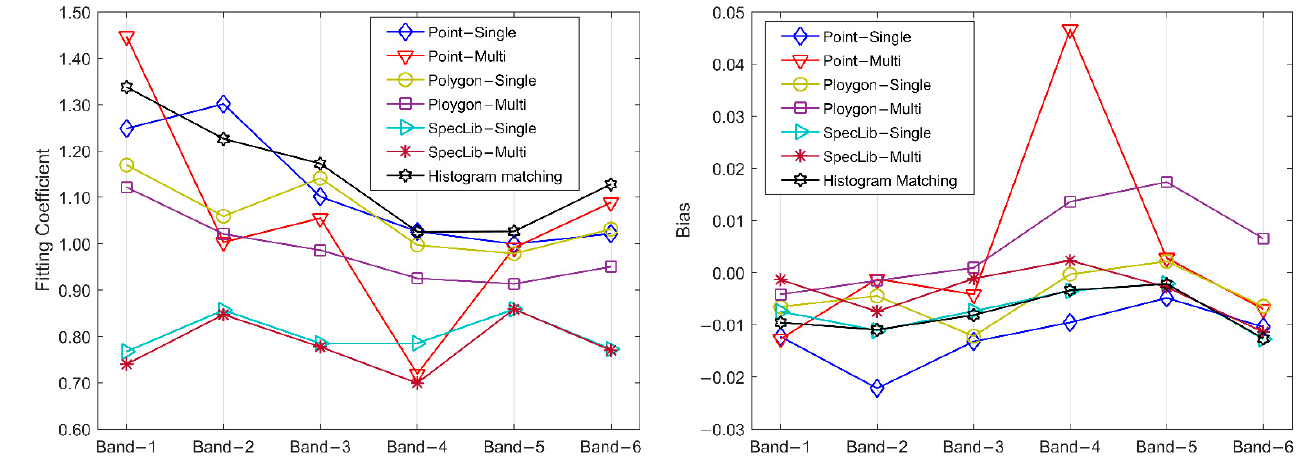
Figure 6. Scatter − fitting coefficient and bias between reference and subject images.